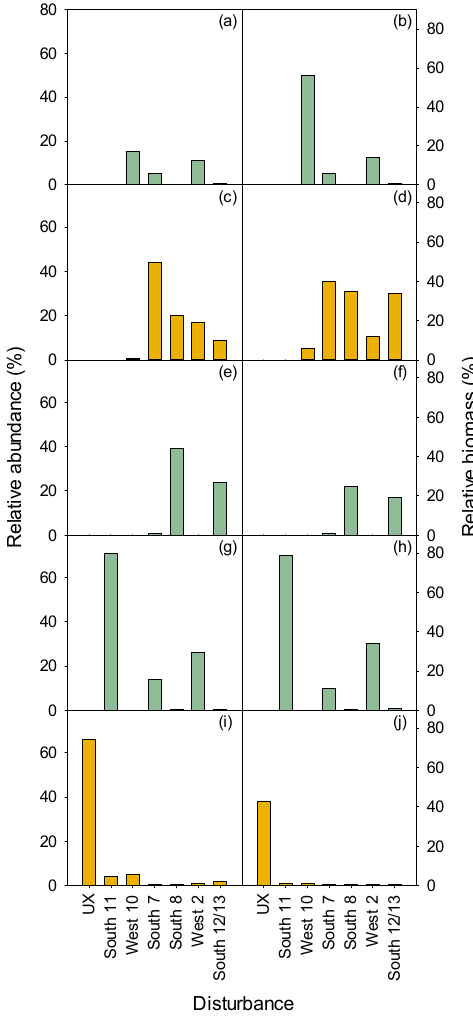
Figure 6. The Xerophyllum tenax (XETE) habitat type phase 30 years after disturbance and the relative abundances (%) for shrubs of high stature ( a ) Alnus viridis ssp . sinuata and ( c ) Salix scouleriana ; medium stature ( e ) Ceanothus velutinus and ( g ) Shepherdia canadensis ; and low stature ( i ) Vaccinium membranaceum , along with their respective relative biomass (%) values ( b , d , f , h , j ). Note: N-fixing shrubs are shown in green; x-axis values progress from undisturbed forest (left) to the highest severity disturbance (right); see Table 1 for disturbance category descriptions.